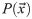
Importance sampling alignment algorithm schematic.Toy example of aligning an RNA sequence CUCUGGAAG to models of its sequence/structure consensus, where the true structural alignment has two nested base pairs (brackets in structure line) and one pseudoknot (‘Aa’). Suboptimal alignments of the sequence are sampled probabilistically using a pHMM. A pHMM does not capture residue correlations due to base-pairing, so only some proposed alignments satisfy the expected consensus nested (cyan) or pseudoknotted (pink) base pairs. The proposed alignments are re-scored and re-ranked under the HPM, which does capture correlation structure; the correct alignment with the highest probability under the HPM is identified (green), and the sequence’s total probability P(x→) is obtained by importance-weighted summation over the sampled alignments.